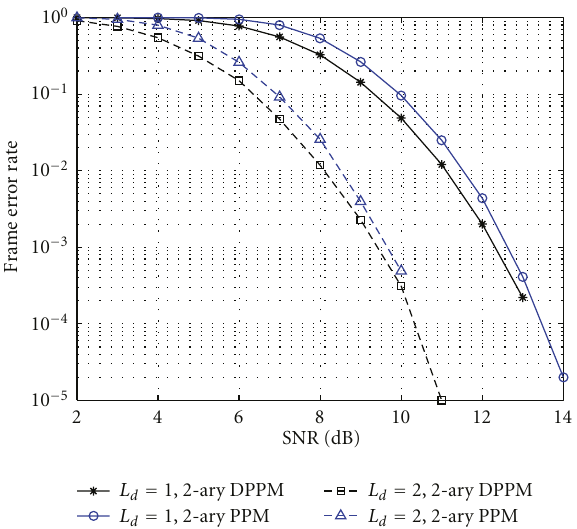
Figure 4: Frame error rate for 4-ary DPPM over Nakagami fading channels with di ff erent m , a frame length of 128bits and receive diversity order L d =